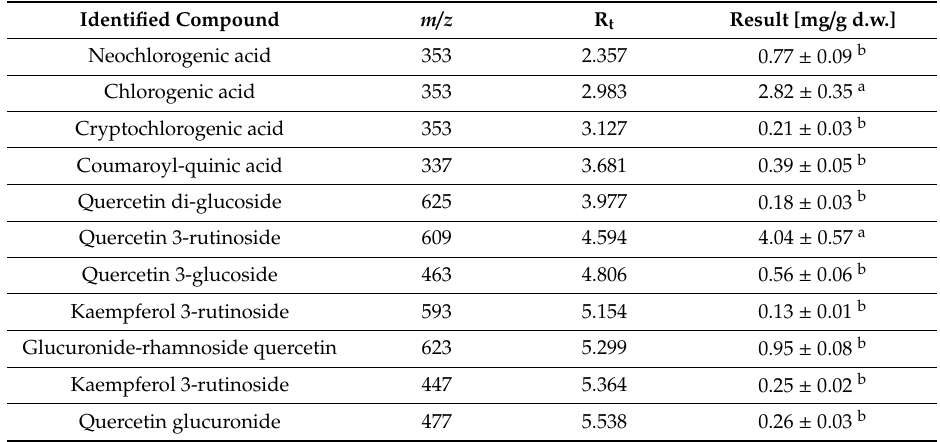
Table 3. The content of individual polyphenols identified in black elder flowers by ultra-performance liquid chromatography (UPLC).